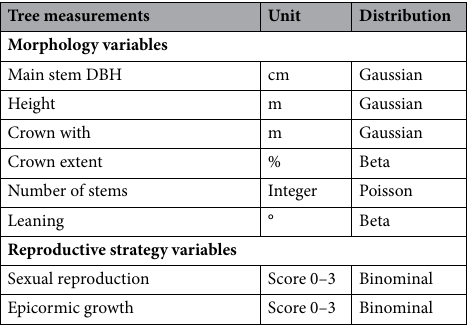
Table 1. Measured morphology and reproduction variables and distribution for model